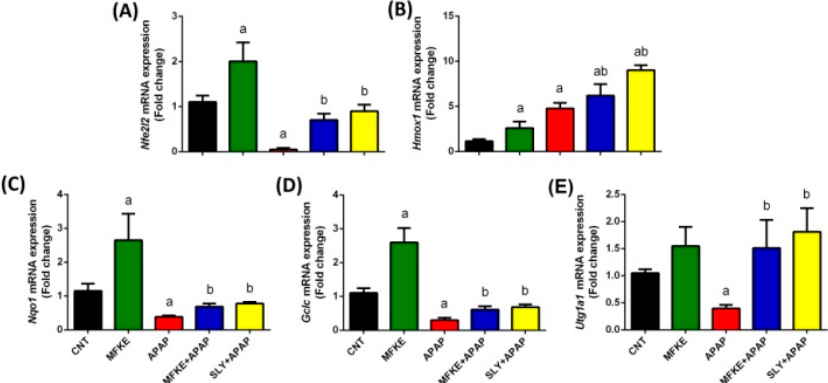
Figure 5. Effects of MFKE on Nrf2/ARE antioxidant signalling pathway gene expression in rats treated with APAP-induced liver toxicity. Results are presented as means ± SD of triplicate assays and normalized to Gapdh and expressed as fold change (log2 scale), relative to mRNA levels in controls; a p < 0.05 vs. control rats; b p < 0.05 vs. APAP-treated rats using Tukey’s post hoc test. ( A ) Nuclear factor erythroid 2–related factor 2, ( B ) Heme oxygenase 1, ( C ) NAD(P)H quinone oxidoreductase 1, ( D ) glutamate-cysteine ligase, catalytic, and ( E ) UDP glucuronosyltransferase family 1 member A1.